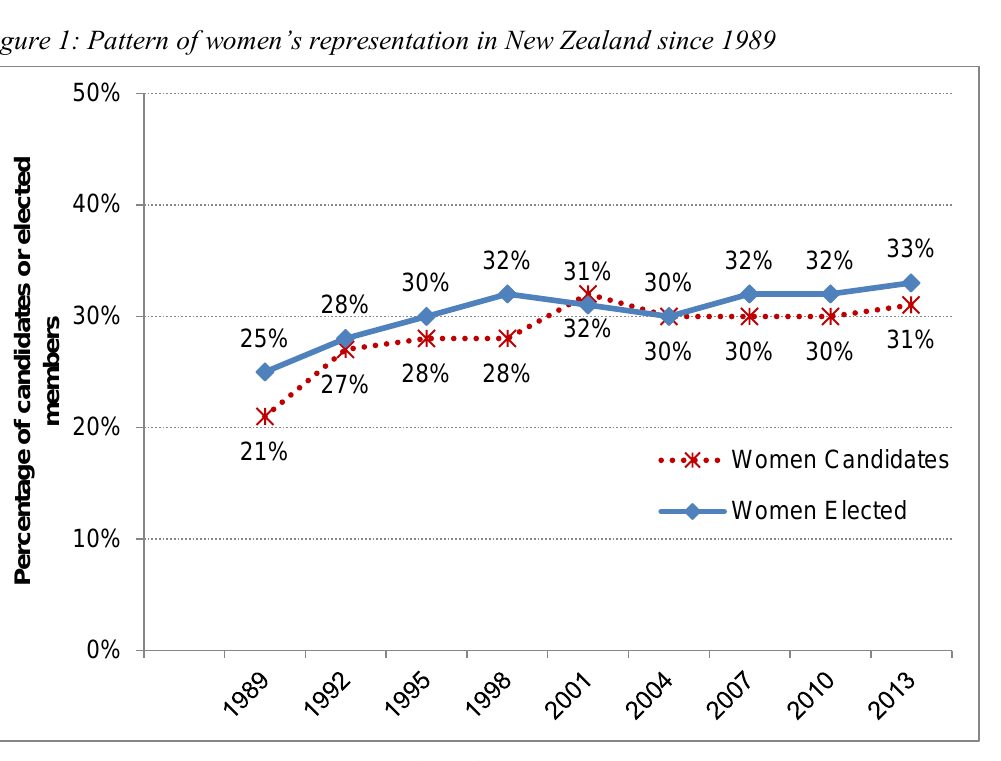
Source: Department of Internal Affairs (2013). Local authority election statistics